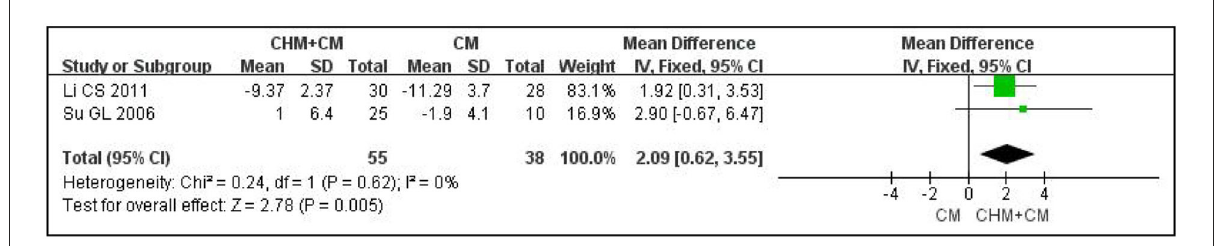
FIGURE4 Forest plot of m-Norris for ALS compared CHM plus CM with CM. m-Norris, modified Norris scales; CHM, Chinese herbal medicine; ALS, amyotrophic lateral sclerosis; CM, conventional medicine.